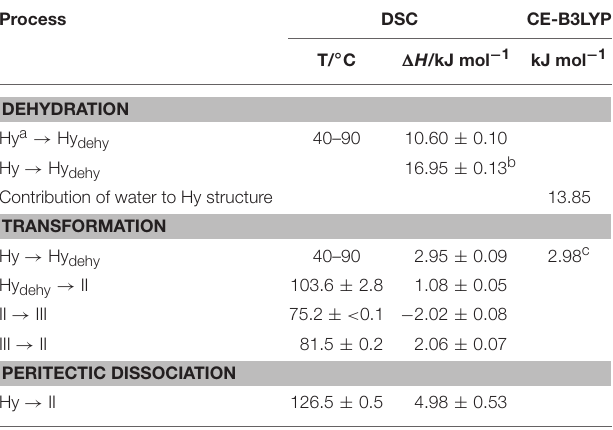
TABLE 3 | Thermochemical data of DDS solid forms (T, temperature; 1 H , enthalpy) obtained starting from the hydrate ( Hy: 0.33 mol water/mol DDS) compared with the CE-B3LYP energy estimation.